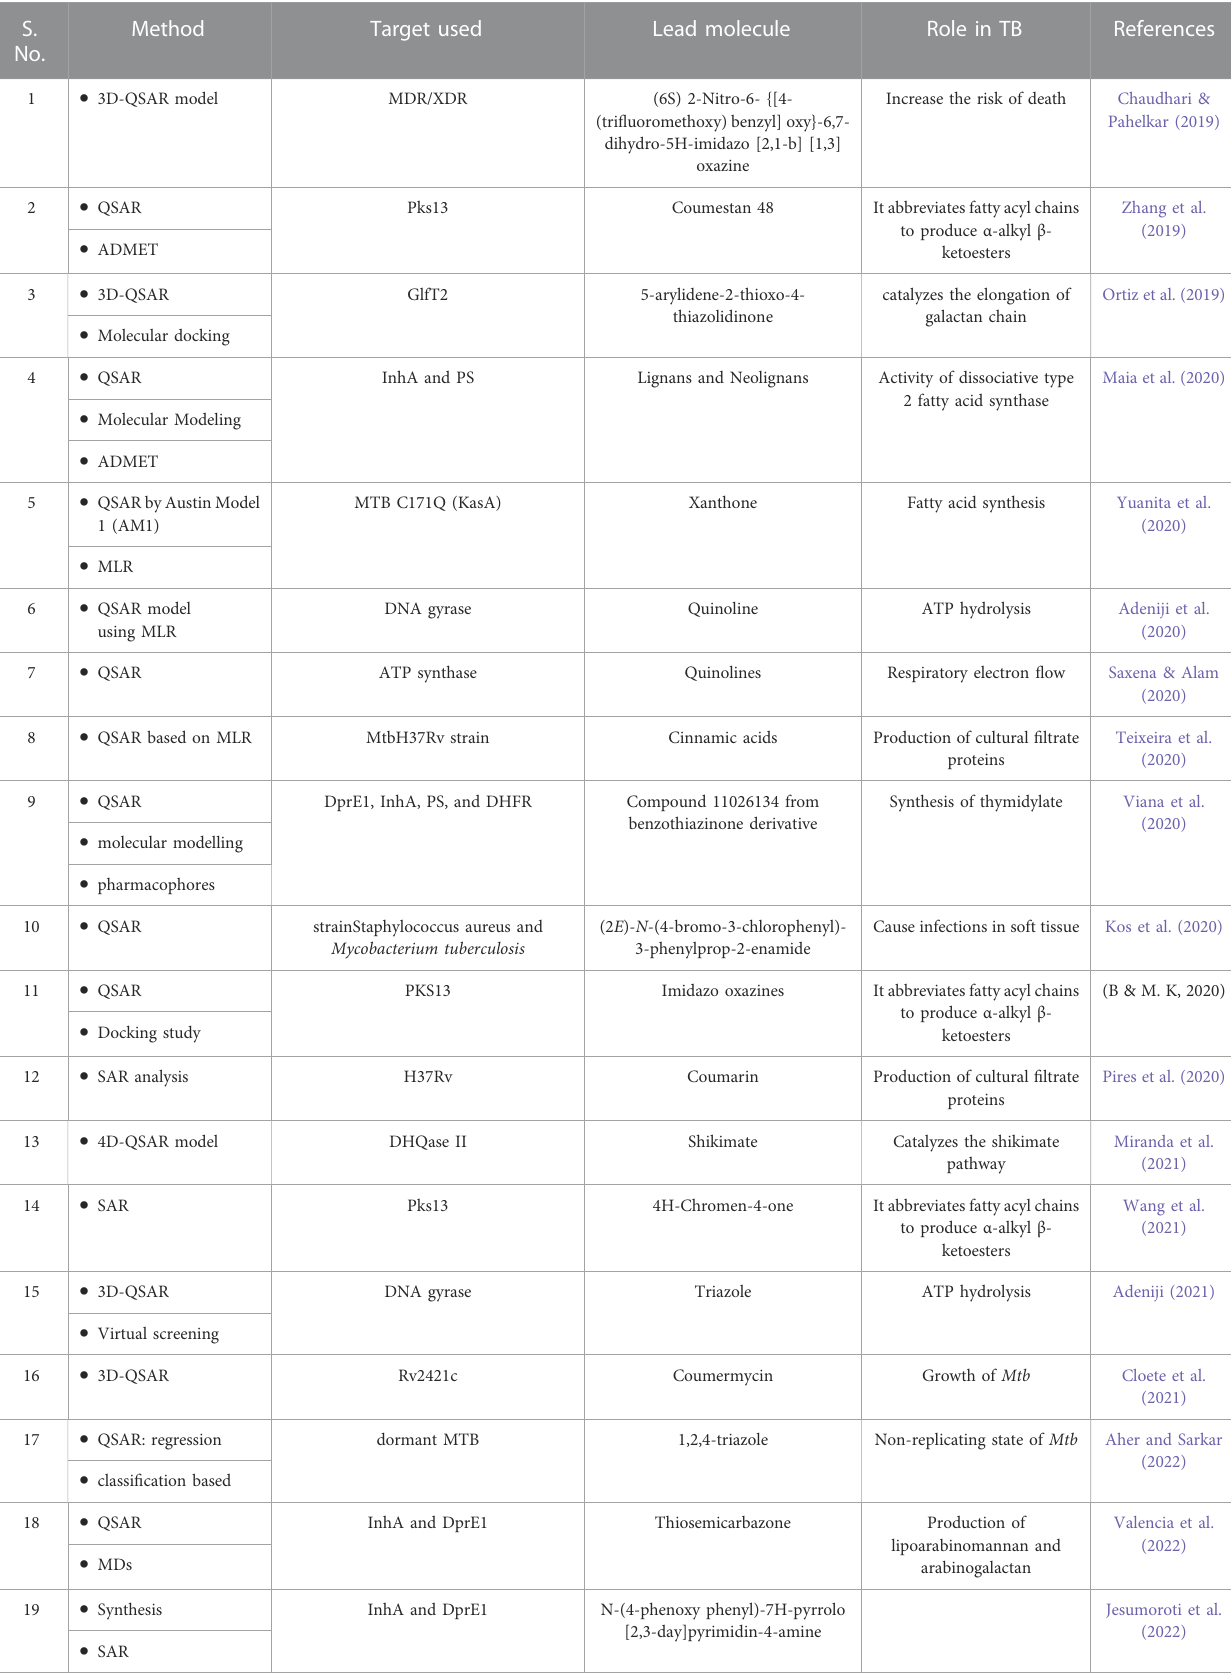
TABLE 3 Studies with Quantitative-Structure Activity Relationship ( QSAR) techniques have been used for TB (LBDD). S.